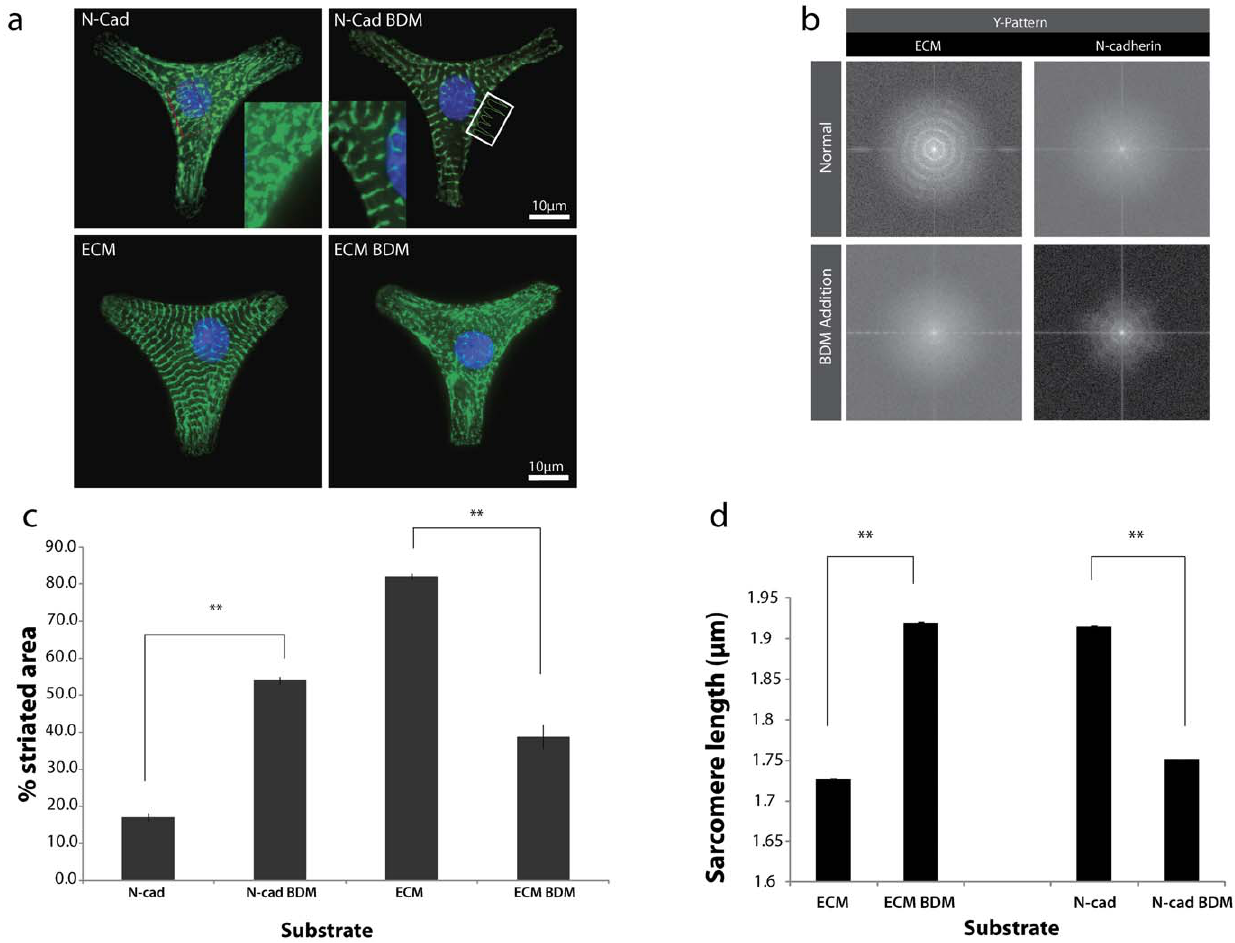
Figure 2. Cardiac myocyte myofibrillar assembly is sensitive to ligand type and contractility. (a) Representative image of myocytes on N- cad and Fn stained for a -actinin (green) demonstrating the appearance of sarcomeres after BDM treatment (inset – zoomed region of the same cells) whereas the opposite effect is observed on Fn. (b) Fourier transform spectra of single myocytes cultured for 72 hours on N-cad and Fn coated micropatterns before and after BDM treatment. a -actinin staining was used to identify repeating patterns/striated myofibrils. Myocytes on N-cad did not show patterned Fourier transform spectra when compared to Fn. However, the repeating patterns appear after BDM treatment on N-cad, whereas on Fn, they are lost. Myocytes patterned on rectangular Fn coated substrates show a uniaxial Fourier spectrum compared to the circular repeated patterns on ‘Y’ shapes indicative of tri-axial anisotropy. (c,d) Quantitative collective measurements of % striated area and sarcomere length (in m m) as a function of substrate composition with and without the addition of BDM show a similar trend. **p , 0.01, error bars 6 1 SEM for 20